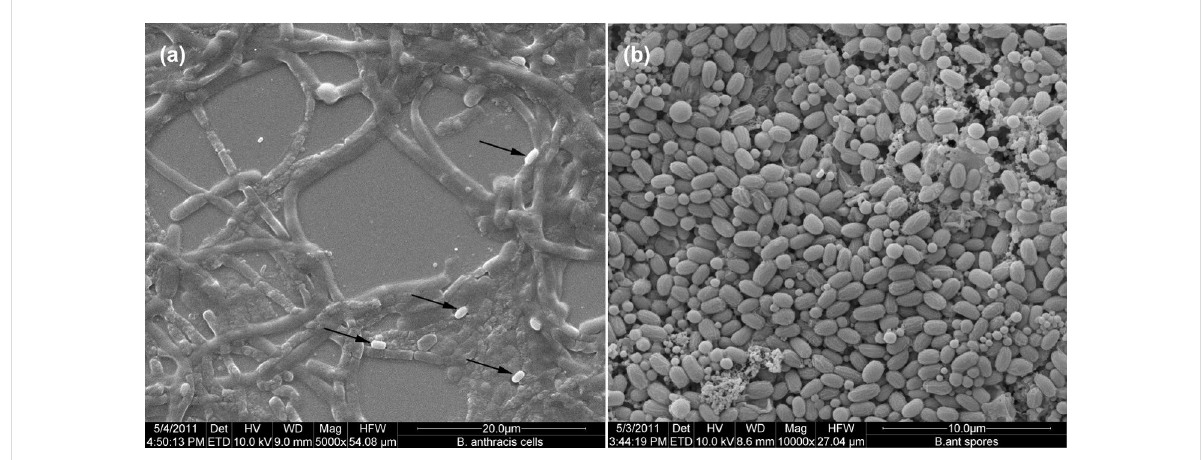
Figure 5: SEM micrographs of a) B. anthracis control cells at 5000× the arrows show occasional spores population present in the cell culture. b) B. anthracis control spores formed in G-media after seven days of incubation at 10000× magnification.